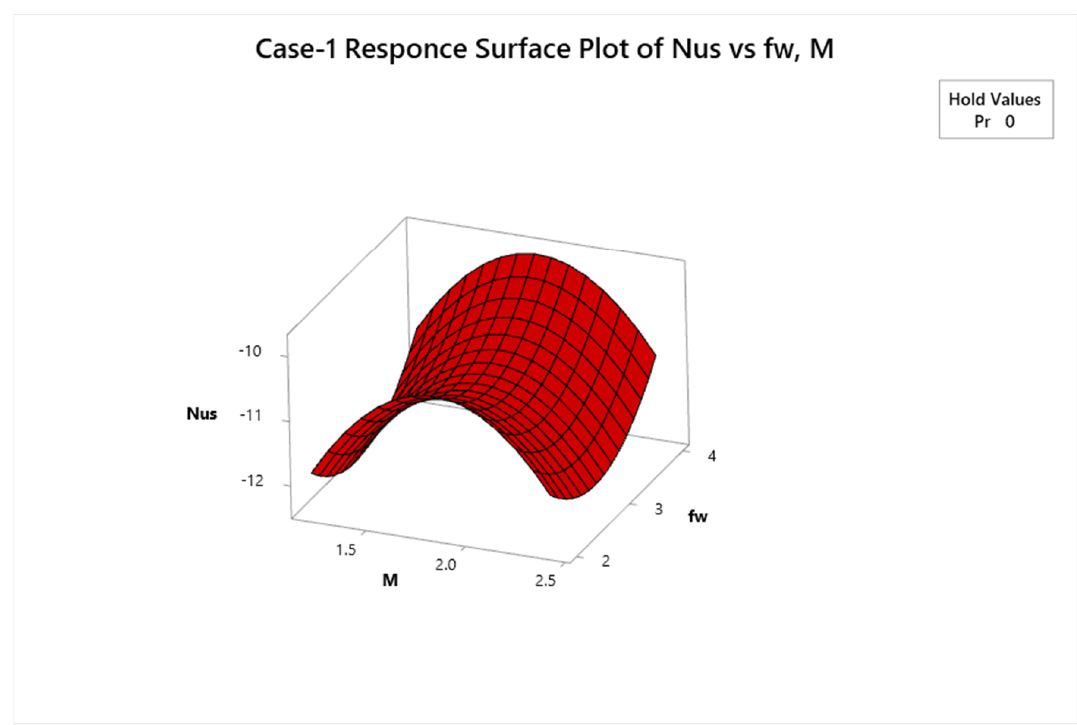
Figure 12. RSM plot for Nusselt number Vs , fw M of Case-1.